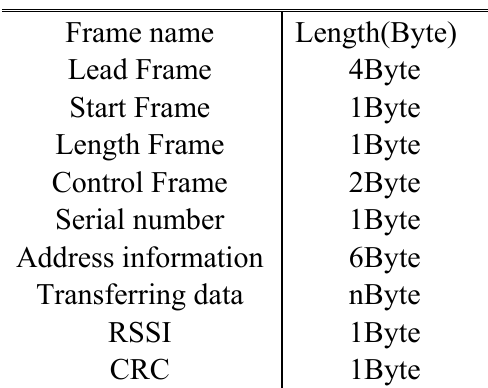
Table 1. Format of the data